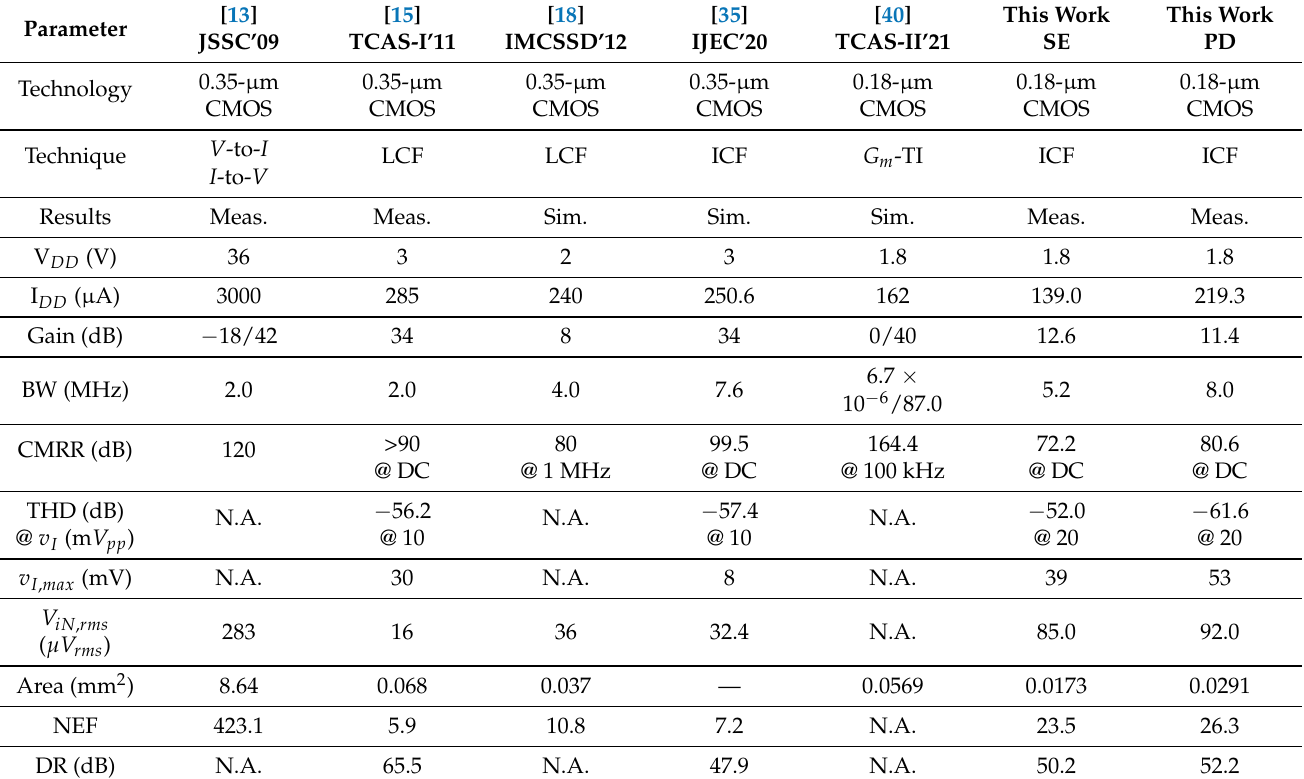
Table 4. Performance comparison of the proposed ICF IAs with other contributions in the